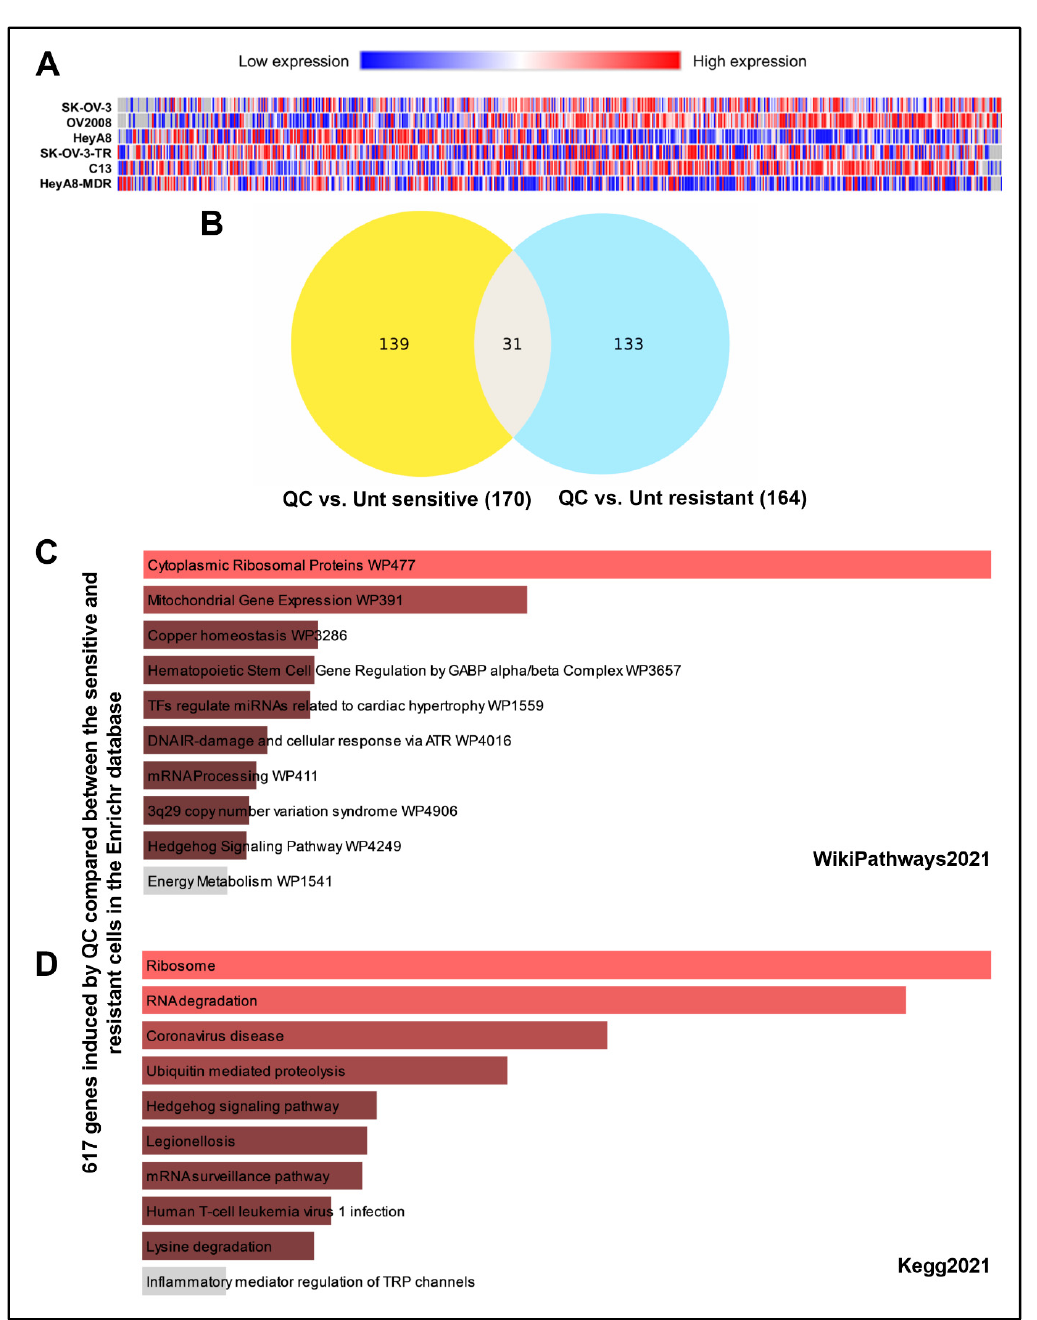
Figure 1. QC-induced differential gene expression in chemotherapy sensitive and resistant isogenic cells. ( A ) Heatmap of 616 gene transcripts identified in secondary analysis of resistant cells to have significant ( p < 0.05) differential gene expression when treated with QC. Shades of blue represent decreases in abundance and shades of red represent increases in abundance. Genes (horizontal axis) are ordered from highest to lowest fold increase in average fold change comparing resistant to sensitive cells treated with QC. ( B ) Venn diagram of differentially expressed genes from quinacrine treatment of sensitive (left) and resistant (right) cells, and genes common to both sets (middle). ( C ) QC-induced 617 genes that differed between the sensitive and resistant cells were analyzed in the Enrichr database and the representative pathway was shown in WikiPathways 2021 and ( D ) KEGG 2021 analysis. Abbreviations: QC: Quinacrine; Unt: Untreated.